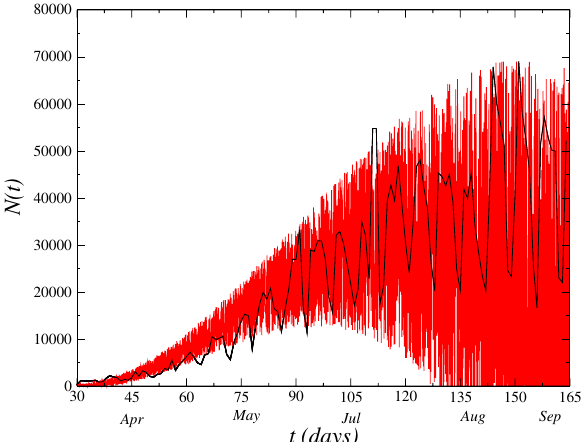
Figure 2. (Left) Dynamics of novel cases N ( t ) in Brazil. The zigzag behavior in the results is reflected by the stochastic term in Eq. (2). We plot the time series of the model Eq. (2) for α 1 as well as β( t ) amplitude Ŵ =